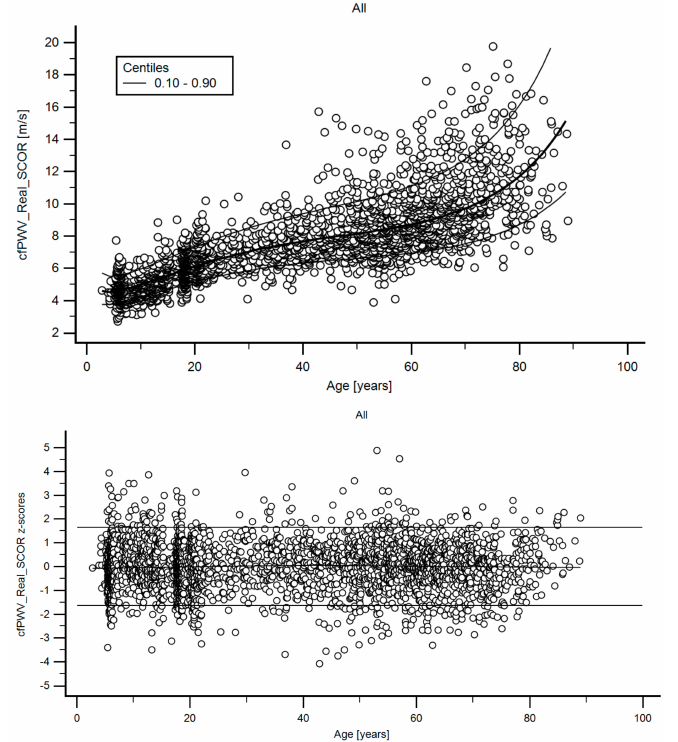
Figure 2. Top : Age-related cfPWV profile (10th, 50th, 90th percentiles). Bottom : z-score diagram used to verify model fit.